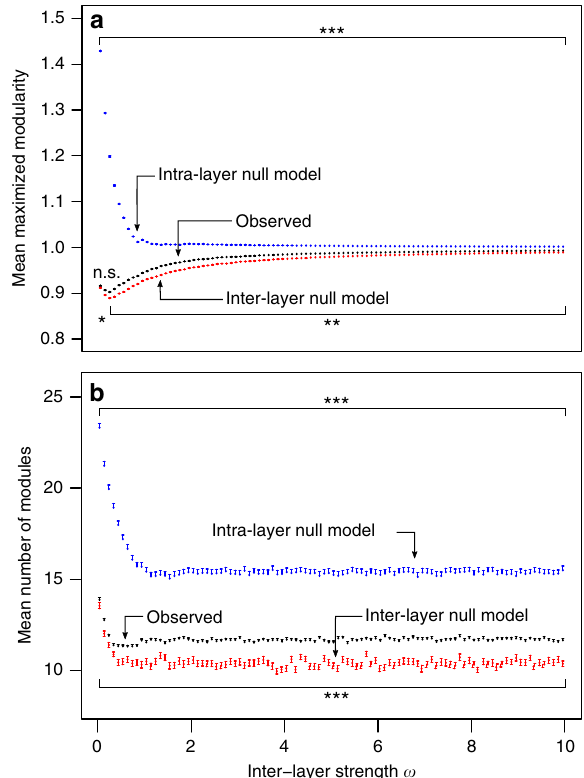
Fig. 2 Modularity and number of modules observed in empirical networks and predicted by two different null models. Mean maximized modularity ( a ) and mean number of modules ( b ) of the observed networks (black) across the range of interlayer strength (0 – 10), and comparison against the two null models: intralayer null model (blue), and interlayer null model (red symbols). Values presented as the mean ( ± SEM) of 100 runs of the modularity function, for each interlayer strength. The signi fi cance of the observed modularity and number of modules was compared against those of the null networks with a one-sample t test. * p < 0.050, ** p < 0.010, *** p < 0.001, n.s. non-signi fi cant. Full results are presented